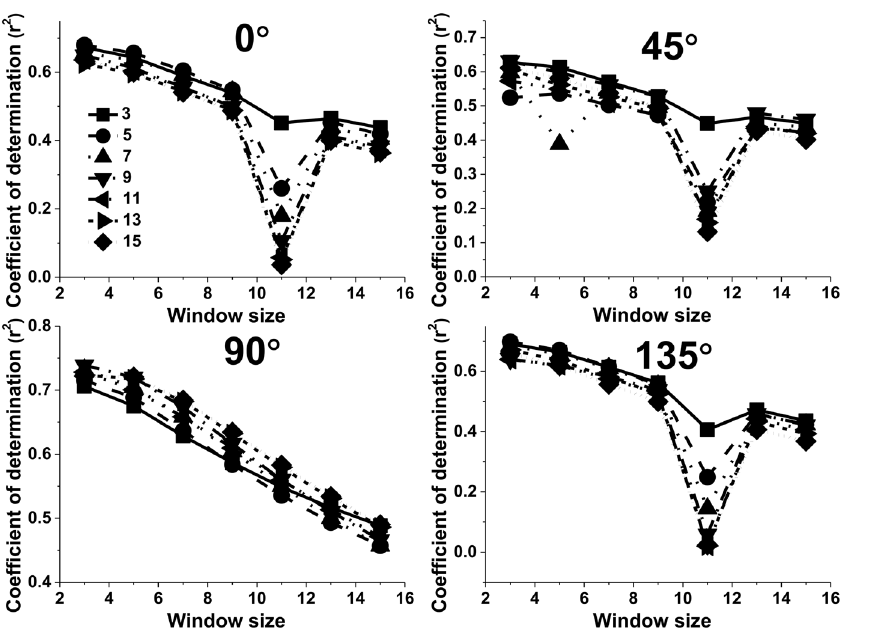
Figure 7. The effect of the window size on the values of adjusted r 2 for